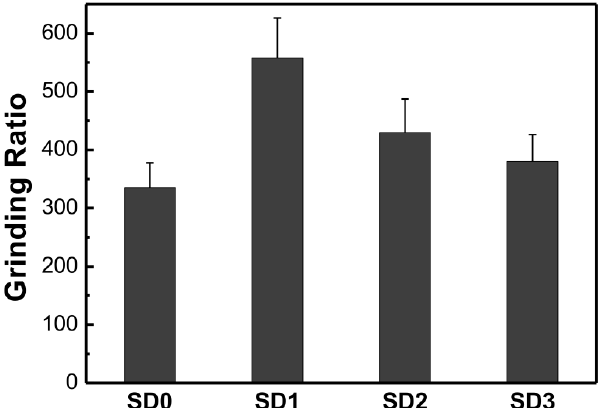
Figure 7. Results of grinding ratio of impregnated diamond samples.